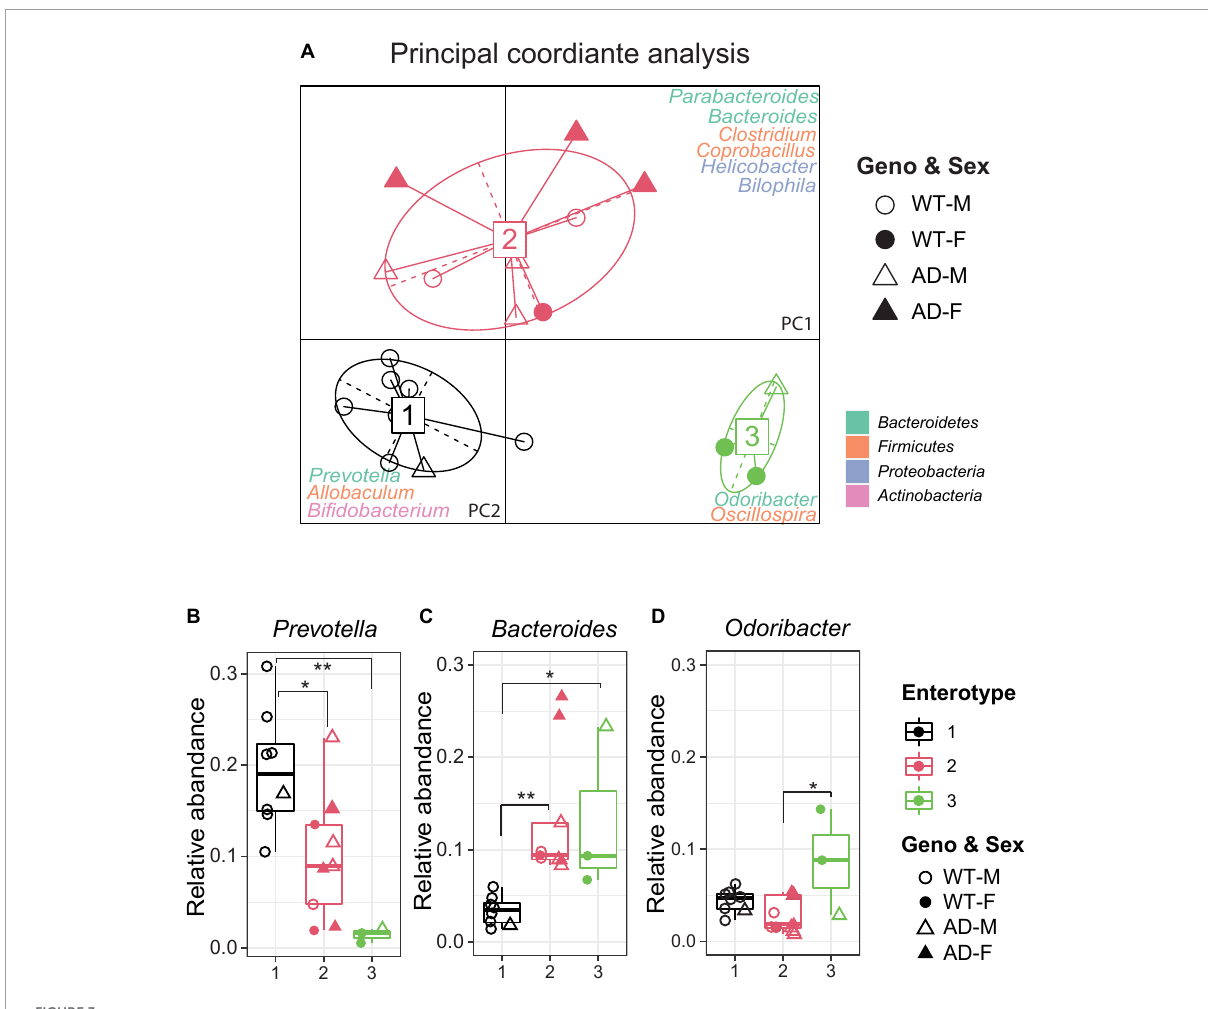
FIGURE3 Enterotypes of the gut microbiome differed between Alzheimer’s disease (AD) and wild-type (WT) mice. (A) Enterotype analysis at the genus level of the gut microbiomes of AD mice ( n = 9, 6 males and 3 females, 12-month-old) and WT mice ( n = 11, 9 males and 3 females, 12-month-old). The data were most naturally separated into three clusters, as determined by the Calinski–Harabasz (CH) index and represented using principal coordinate analysis (PCoA). The corresponding phylum is labeled by colors separately. (B–D) Representative genera of each enterotype: Enterotype 1 is represented by Prevotella , Enterotype 2 is represented by Bacteroides , and Enterotype 3 is represented by Odoribacter . Data are shown as all samples with a boxplot. F, females; M, males. * P < 0.05, ** P < 0.01, one-way analysis of variance (ANOVA) followed by Tukey’s multiple